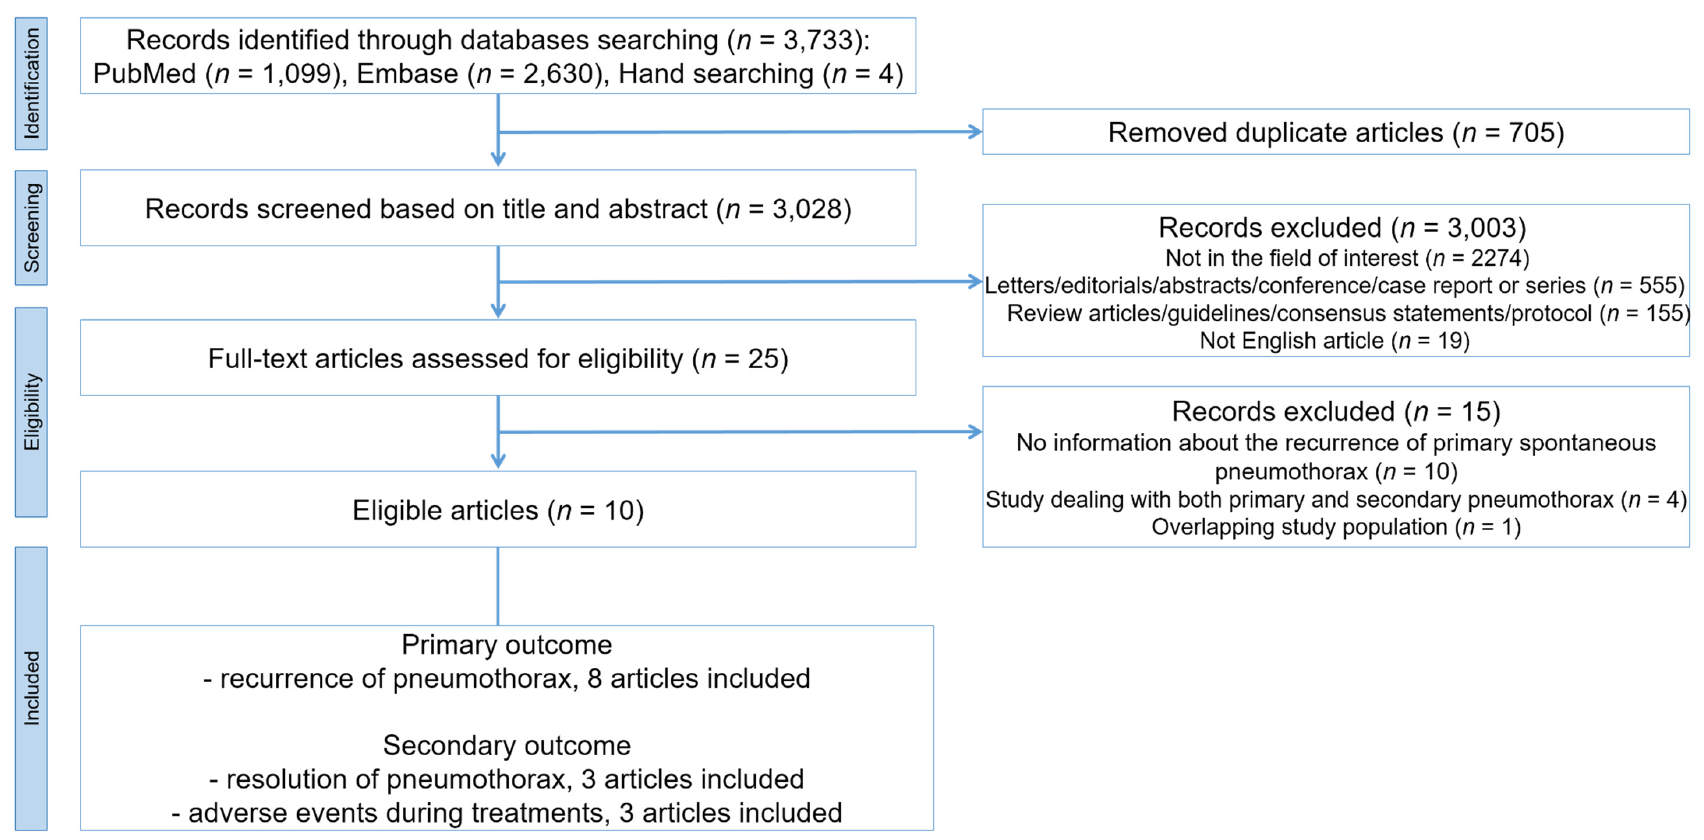
Figure 1. Flow diagram of the literature search.